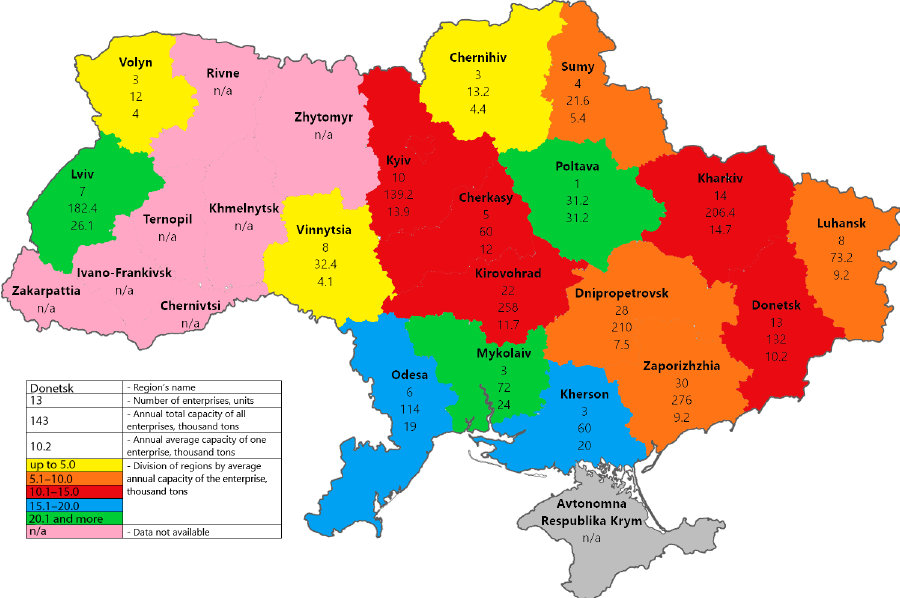
Figure 4. Grouping of regions by average annual capacity of one enterprise for the production of pellets, thousand tons/year (source: based on Lysohor,